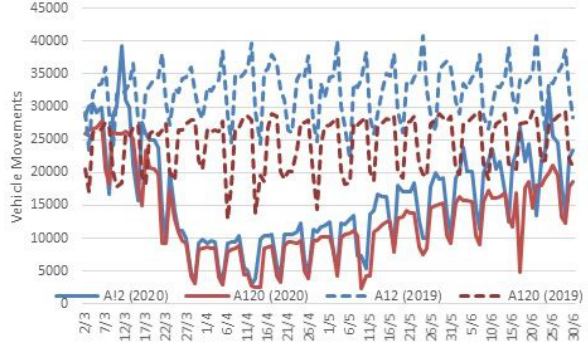
Figure 12: Local daily vehicle movements over the lockdown period and the same period the previous year for the two case studies [20]